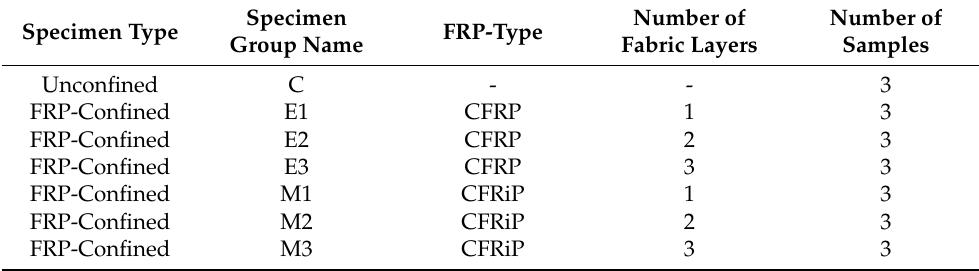
Table 2. The details of the testing